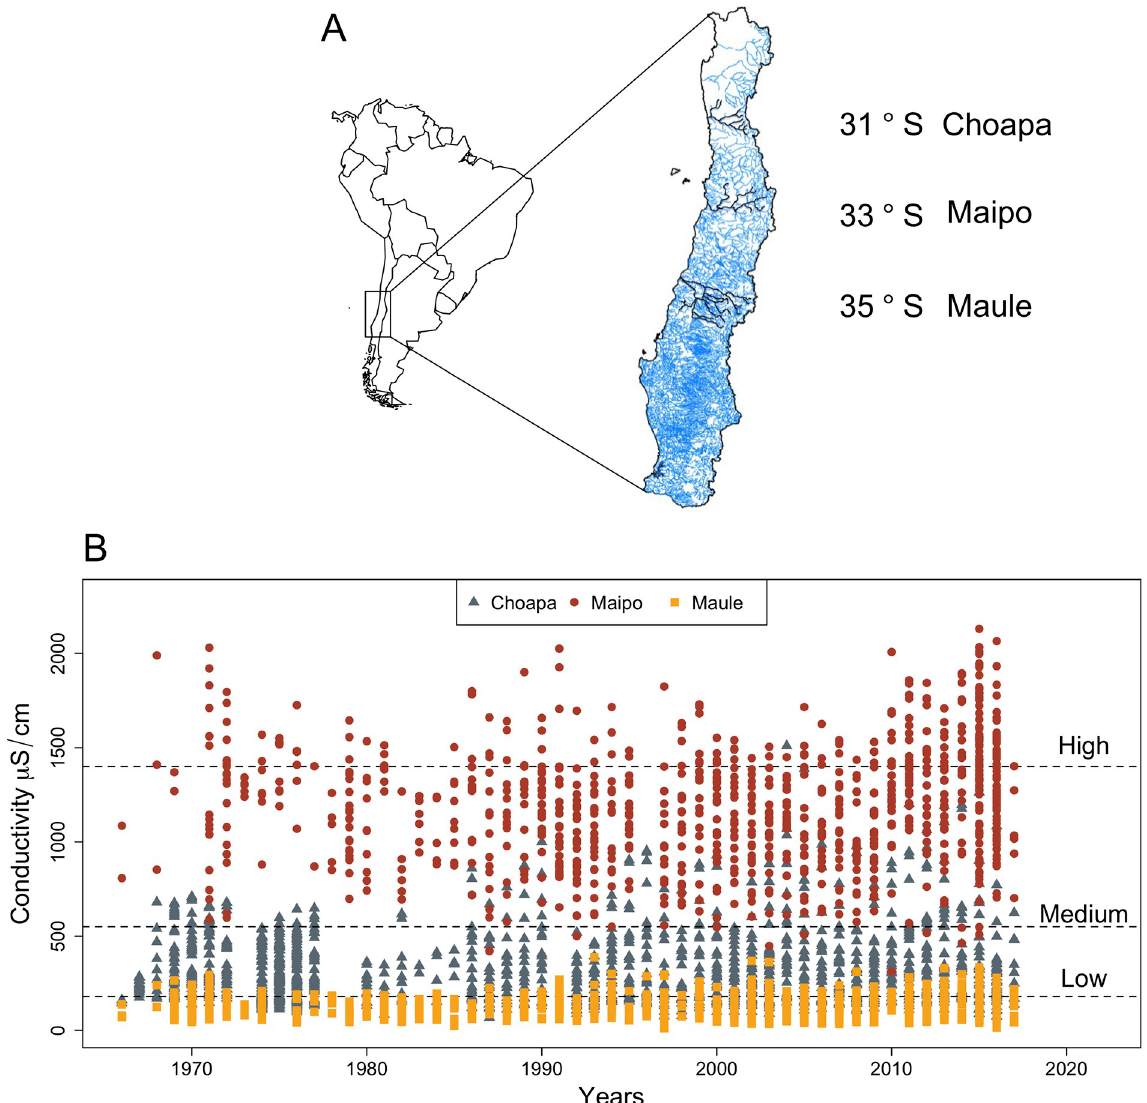
Fig 1. Main features of the study sites. A: Geographical location of the hydrological basins Choapa, Maipo and Maule in central Chile. B: Values of electric conductivities recorded for the three hydrological basins by the DGA (Direccio´n General de Agua, Chile; http://snia.dga.cl/ BNAConsultas/reportes) at the monitoring water quality stations during the last 50 years. Horizontal dashed lines indicate the three experimental conductivity levels used in our study.